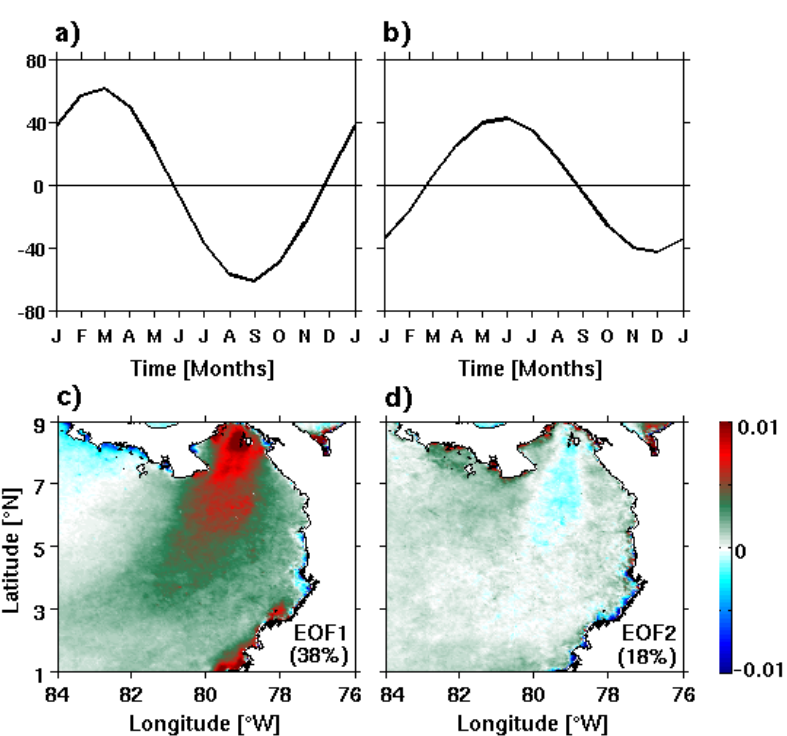
Figure 3. Principal two Empirical Orthogonal Function (EOF) spatio-temporal modes of the climatological annual cycle of the total Chl-a in the Panama Bight region. ( a , b ) Annual harmonics of the temporal EOF modes, and ( c , d ) corresponding spatial EOF modes.